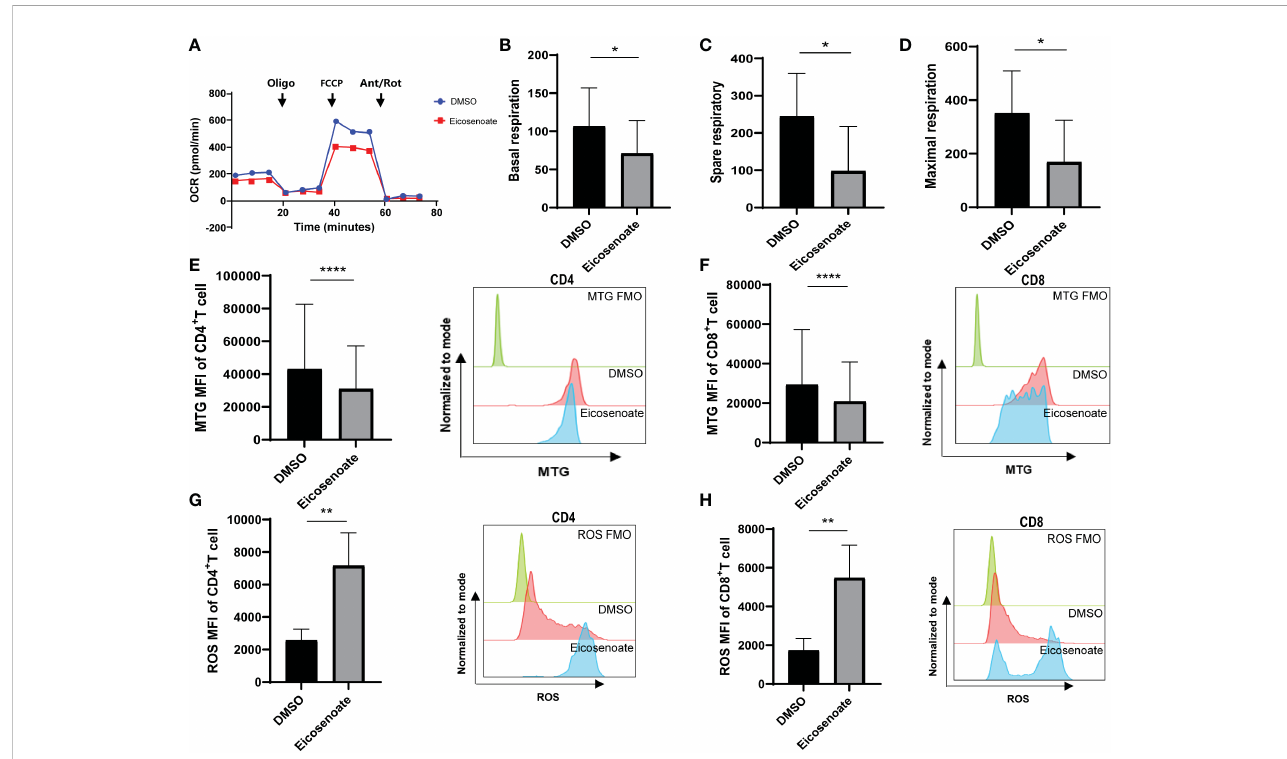
FIGURE 3 The lipid metabolite eicosenoate impairs T-cell mitochondrial function. (A) Oxygen consumption rate (OCR) at baseline and after administration of 1.5 m M oligomycin (oligo), 1 m M FCCP, and 0.5 m M antimycin + rotenone (Ant/Rot) after 24 h stimulation of CD3 + T cells with 500 m M eicosenoate and ImmunoCult Human CD3/CD28 T-cell Activator. (B-D) Basal respiration (B) , spare respiratory (C) and maximal respiration (D) were calculated and compared between eicosenoate-stimulated cells and controls and results are shown (n = 4). (E, F) The mitochondrial mass of primary CD3 + T cells was marked using MitoTracker Green after co-incubation with 500 m M eicosenoate and anti-CD3/CD28-coated Dynabeads (4:1 ratio) for 24 h. Both CD4 + ( P < 0.0001) and CD8 + ( P < 0.0001) T-cell mitochondrial mass were signi fi cantly decreased (n = 15). (G, H) Mitochondrial ROS in primary CD3 + T cells were marked using MitoSOX Red Mitochondrial Superoxide Indicator. After co-incubation with 500 m M eicosenoate and anti-CD3/CD28-coated Dynabeads (4:1 ratio) for 24 h, mitochondrial ROS in CD4 + ( P < 0.01) and CD8 + ( P < 0.01) T cells were signi fi cantly increased (n = 10). In each panel, representative fl ow cytograms and comparisons of the parameters between eicosenoate-stimulated cells and controls are shown. * P < 0.05, ** P < 0.01, and **** P < 0.0001. P values were calculated by Paired t-test (B-D) , Wilcoxon matched-pairs signed rank test (E – H)